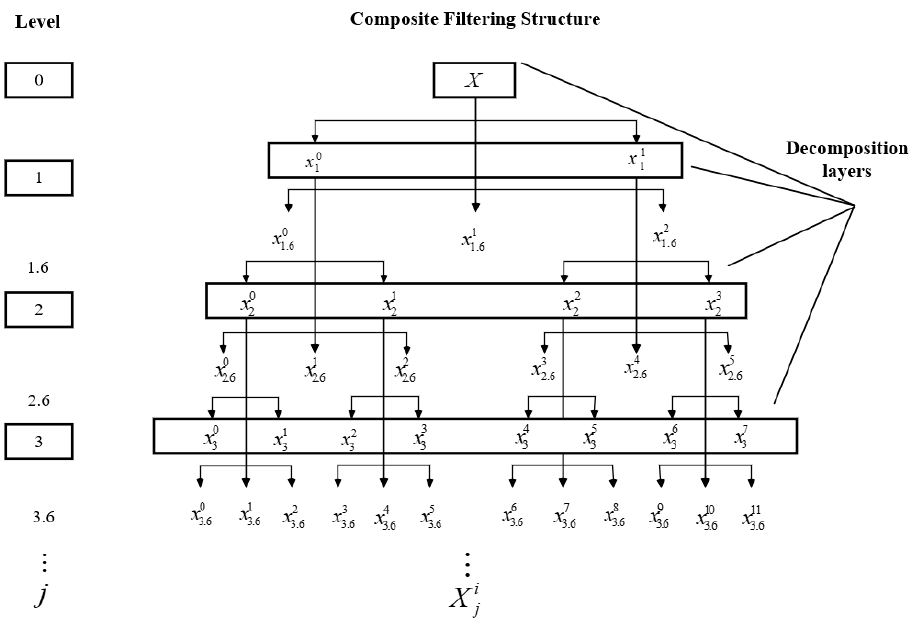
Figure 3. The production of three of the filter bands.